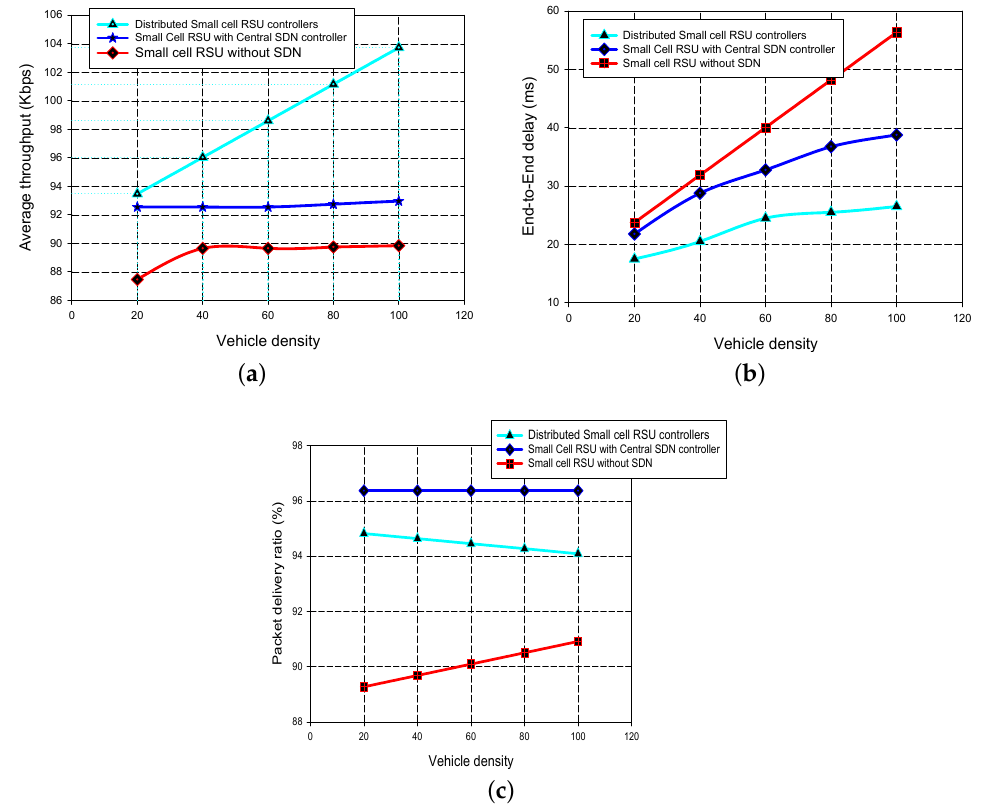
Figure 4. Impact of intelligence based on SDN controller over the proposed architecture versus vehicle density: ( a ) average throughput; ( b ) E2E delay; ( c ) packet delivery ratio